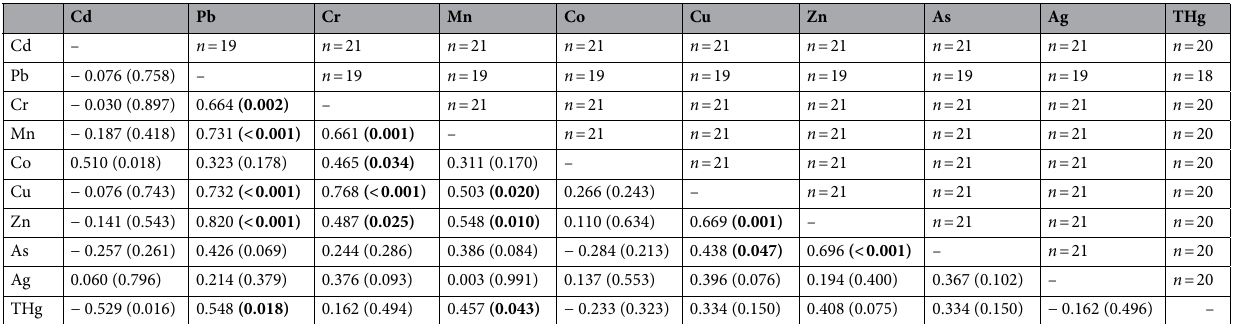
Table 3. Correlation coefficients (p value) for Spearman’s correlation tests examining relationships between trace metal concentrations in the muscle tissue of Caribbean Reef sharks. Bold indicates statistically significant correlation at α = 0.05 level. Sample sizes for each specific comparison are shown in the second